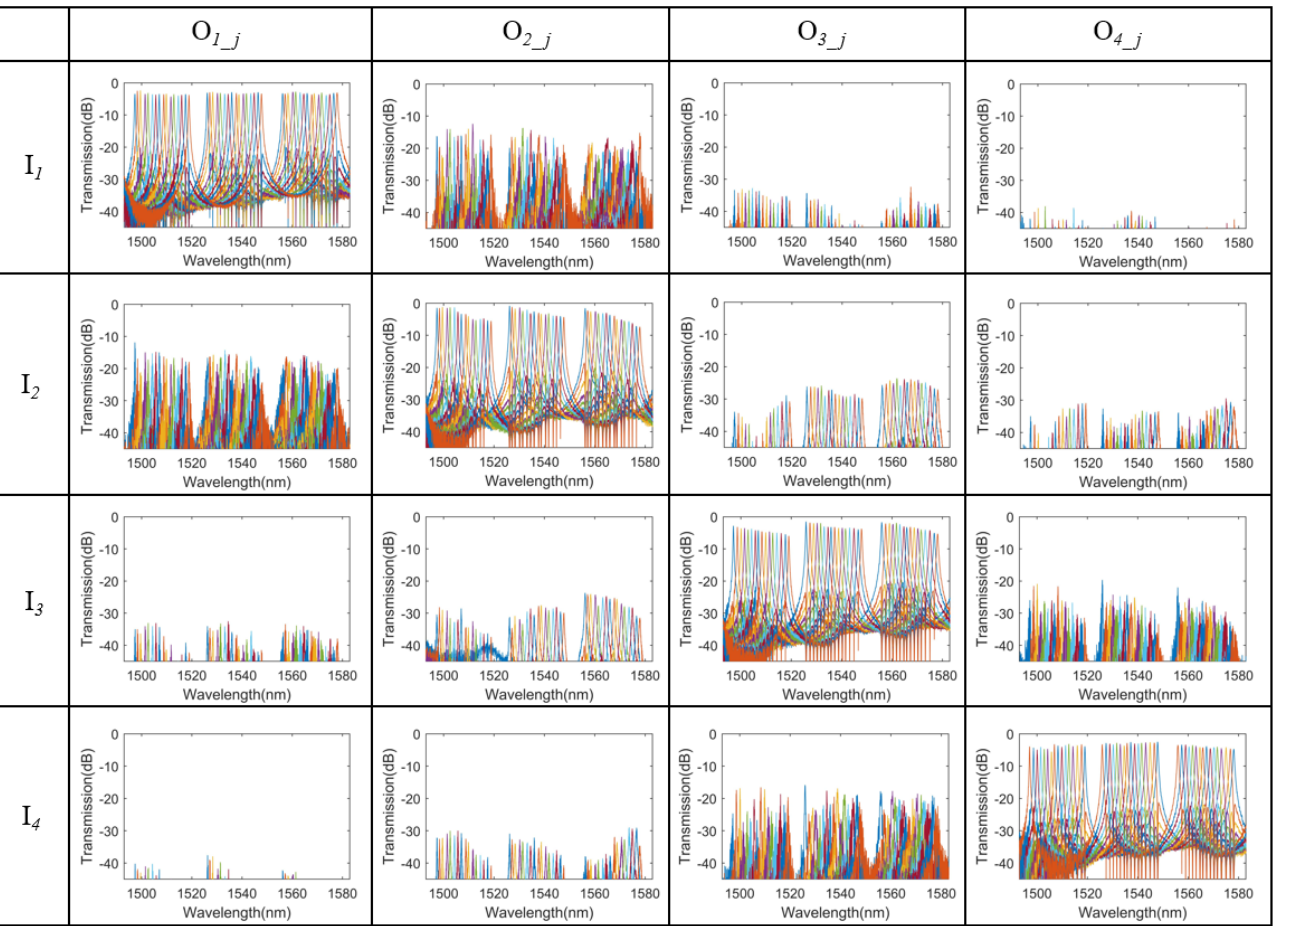
Figure 6. Measured spectral responses of the 64-channel hybrid WDM–MDM (de)multiplexer when light is launched from I 1 , I 2 , I 3 , and I 4